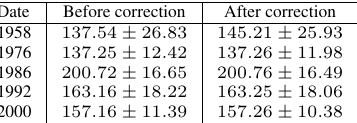
Table 2. Average and standard deviation of pixel values, before and after correction, for each of the studied